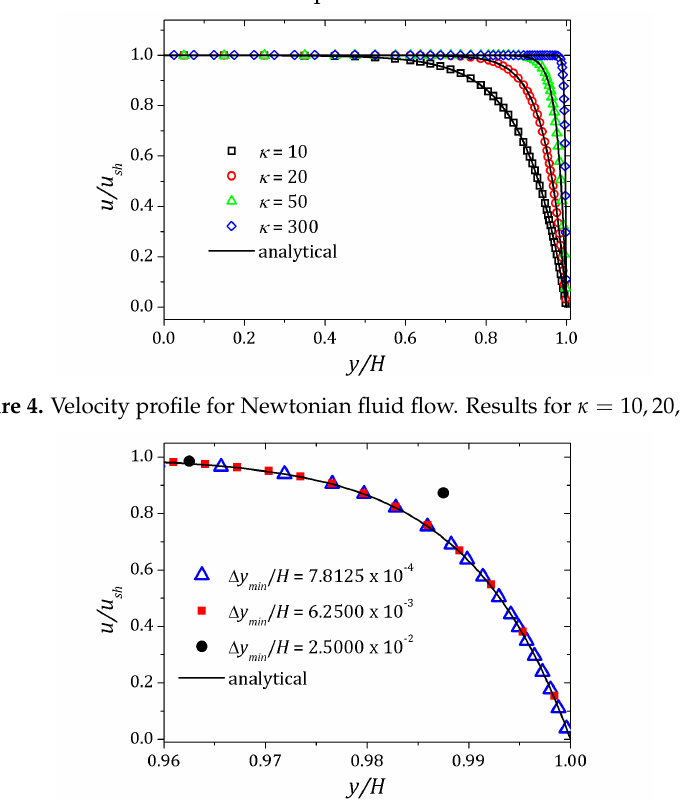
Figure 5. Effect of mesh refinement. Velocity profile of a Newtonian fluid subjected to electro-osmotic forces in a channel. We fixed κ = 100 and vary the refinement near the wall. Image is zoomed near the wall to improved visualization of the